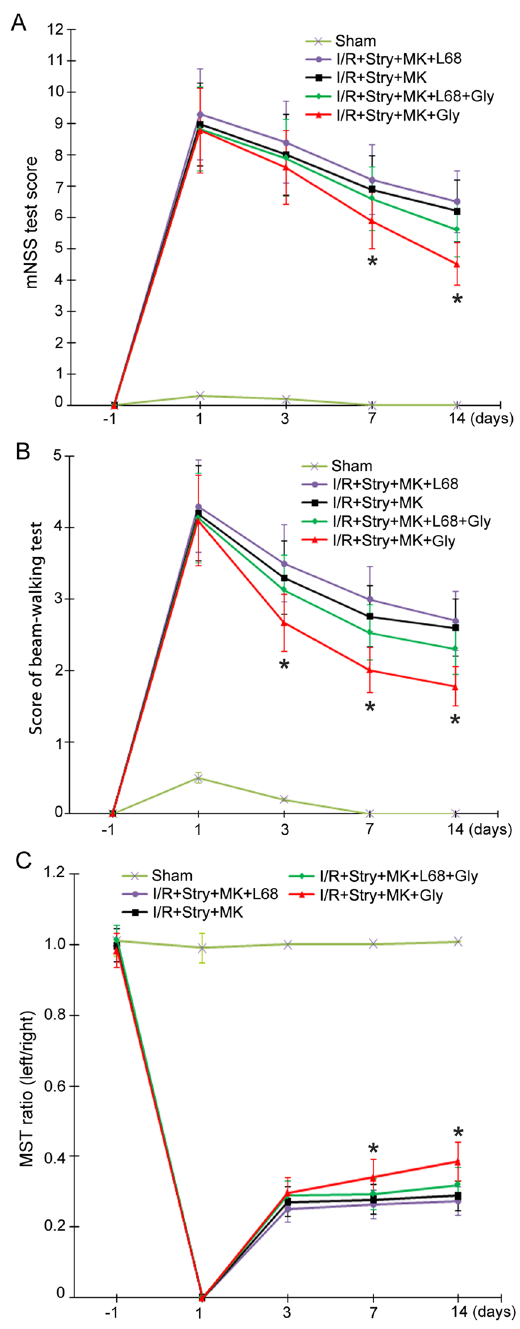
Figure 6. Glycine-GluN1 binding site antagonist prevents glycine-induced functional recovery of ischemic stroke animals. For all the three experiments, Glycine (100 µ g/100 g, icv) was administered at 3 h following I/R. Glycine-GluN1 binding antagonist L-689560 (L68; 0.1 mg/100 g, ip) is injected with MK-801 and strychnine at 30 min before glycine injection. ( A ) Animals treated with glycine (100 µ g/100 g, icv) has lower scores of mNSS test at day 7 and 14 compared with I/R + Stry + MK + L68 + Gly group (n = 10; ANOVA test, * P < 0.05, vs. I/R + Stry + MK + L68 + Gly). ( B ) Animals treated with glycine has lower scores of beam-walking test at day 3, 7 and 14 compared with I/R + Stry + MK + L68 + Gly group (n = 10; ANOVA test, * P < 0.05, vs. I/R + Stry + MK + L68 + Gly). ( C ) Animals treated with glycine (100 µ g/100 g, icv) treatment has higher ratio in MST test at day 7 and 14 compared with I/R + Stry + MK + L68 + Gly group (n = 10; ANOVA test, * P < 0.05, vs. I/R + Stry + MK + L68 + Gly). Stry: Strychnine; Gly: glycine; MK: